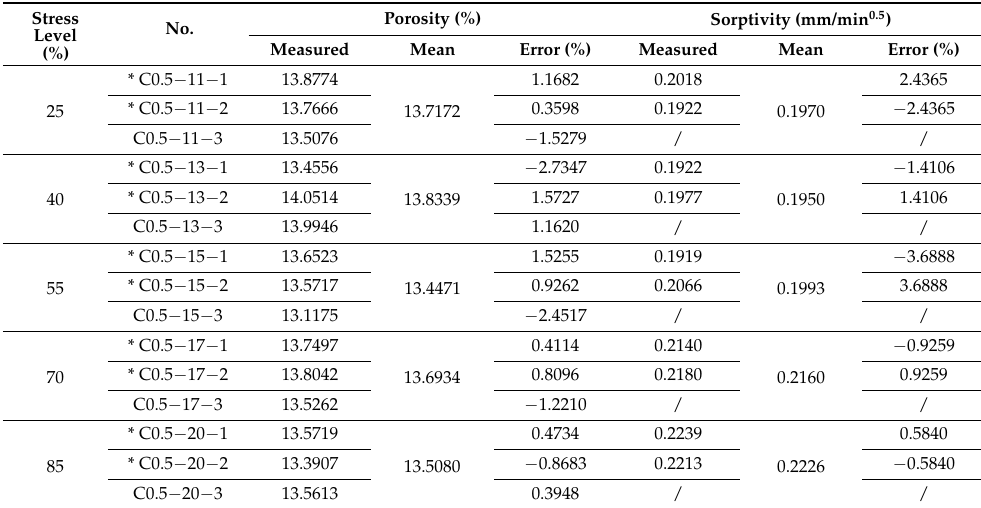
Table 4. Measured porosities and sorptivities of damaged concrete specimens (w/c = 0.5).